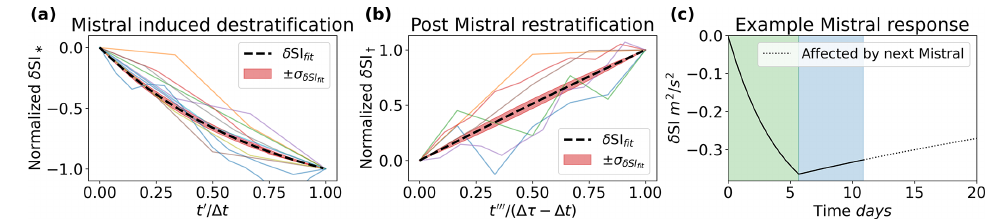
Figure 11. The normalized theoretical solutions (Eqs. A42 and A48) for during (a) and after (b ) a destratification event fitted to the ideal mistral events from Table 1 and δ SI values from the NEMO results in Fig. 8. A value of 0.235d − 1 for α d and a value of 0.021d − 1 for α a was found. Panel (c) shows the δ SI response using the determined restoration coefficients, given an ideal Mistral event with the average values of 5.69d for the duration and 10.88d for the period. The average strength of a mistral, δF = 4 . 01 × 10 − 8 s − 2 d − 1 , was taken from values found in Table A1 from Appendix